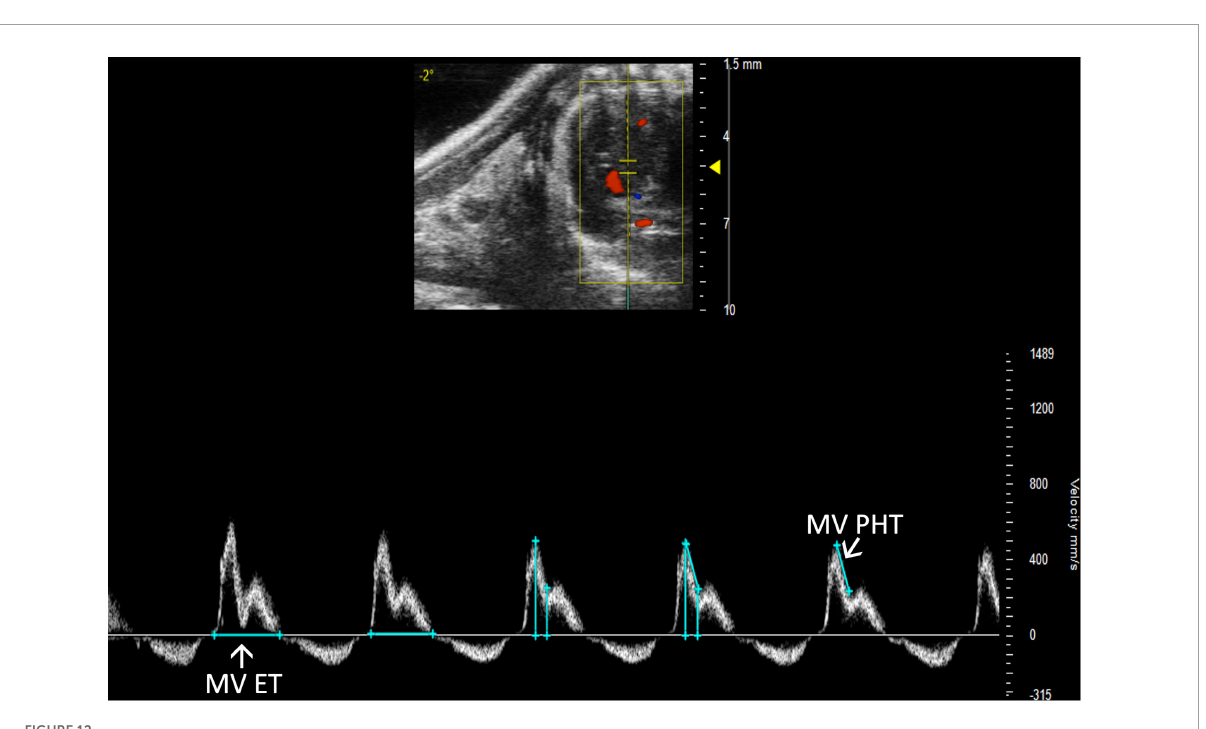
FIGURE12 Pulsed wave (PW) Doppler mode image showing mitral valve pressure half time (MV PHT), a measure of mitral stenosis and mitral valve ejection time (MV ET), the duration of diastolic filling in the left